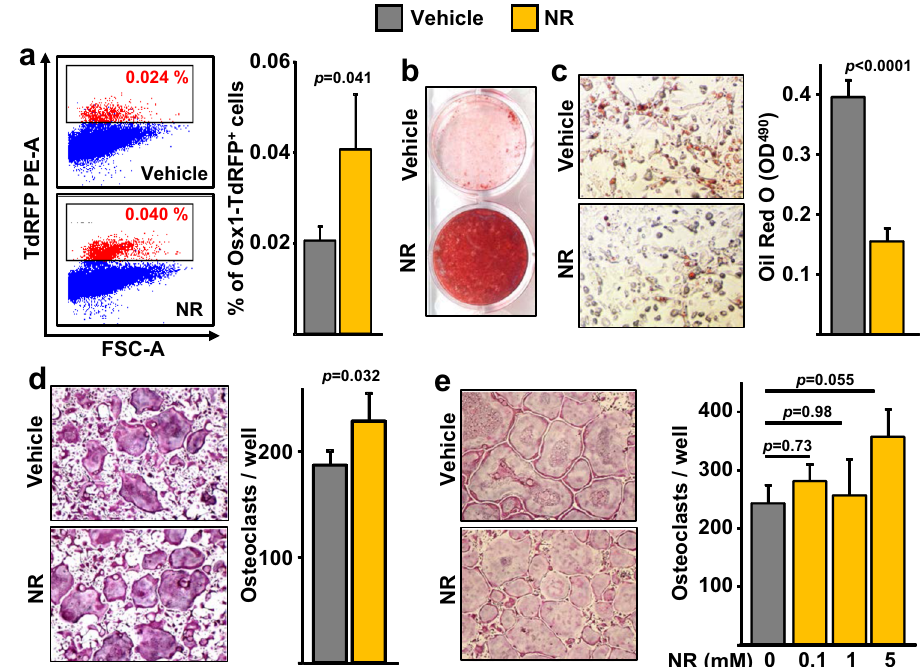
Fig. 5 Administration of NR to aging mice increases osteoprogenitor number. a Representative fl ow cytometry analysis (left) and percentage (right) of Osx1-TdRFP + cells in the bone marrow of 20-month-old Osx1-Cre;TdRFP mice treated without or with 12 mM NR for 8 months ( n = 4 mice/group). b Representative images of Alizarin Red staining of bone marrow stromal cells, from mice described in Fig. 3, cultured under osteogenic conditions for 21 days. c Representative images (left) and quanti fi cation (right) of Oil Red O Staining in bone marrow stromal cells, from mice described in Fig. 3, cultured under adipogenic conditions for 10 days (triplicate cultures). d , e Representative images (right) and quanti fi cation (left) of TRAP-positive osteoclasts containing three or more nuclei in cultures of bone marrow macrophages with M-CSF and RANKL for 5 days, from mice described in Fig. 3 (quadruplicate cultures) ( d ); or from untreated 24-month-old C57BL/6 female mice in the presence of the indicated doses of NR (quadruplicate cultures) ( e ). Data represent mean ± SD; p values by two-tailed t -test ( a , c , d ) or one-way ANOVA ( e